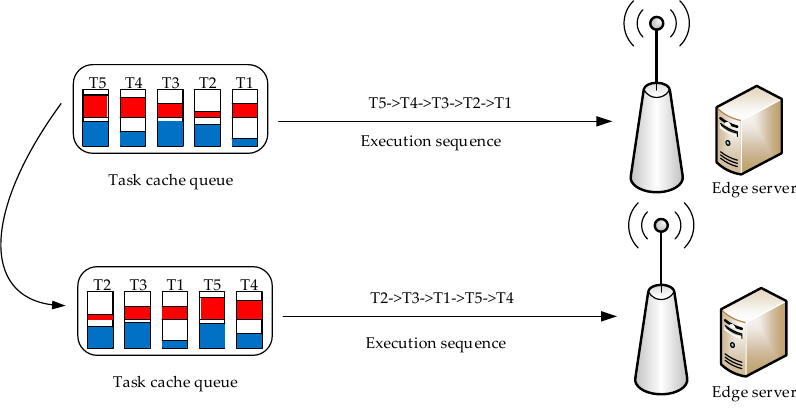
Figure 3. The execution sequence before and after using the task priority.